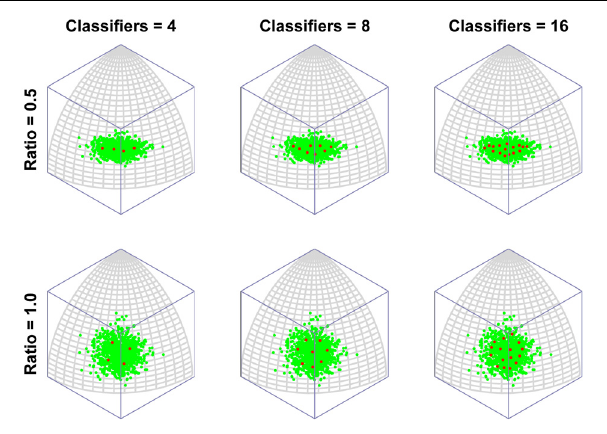
FIGURE 2 | The emergence of multidimensional (holistic) selectivity in neural classifiers. The six plots represent outcomes of the simulation. From left to right the number of neural classifiers increases. From top to bottom relative levels of variance in two orthogonal dimensions of face space are tested. The variable “Ratio” controls the ratio of the standard deviation of the less variable dimension (Dimension 1, running along lines of longitude) to that of the fixed dimension (Dimension 2, running along lines of latitude). For large discrepancies in variance and small numbers of classifiers, the classifiers align with Dimension 2, completely ignoring variation in the minor dimension. Increasing the number of classifiers or the variance in Dimension 1, sees classifiers becoming sensitive to both dimensions.